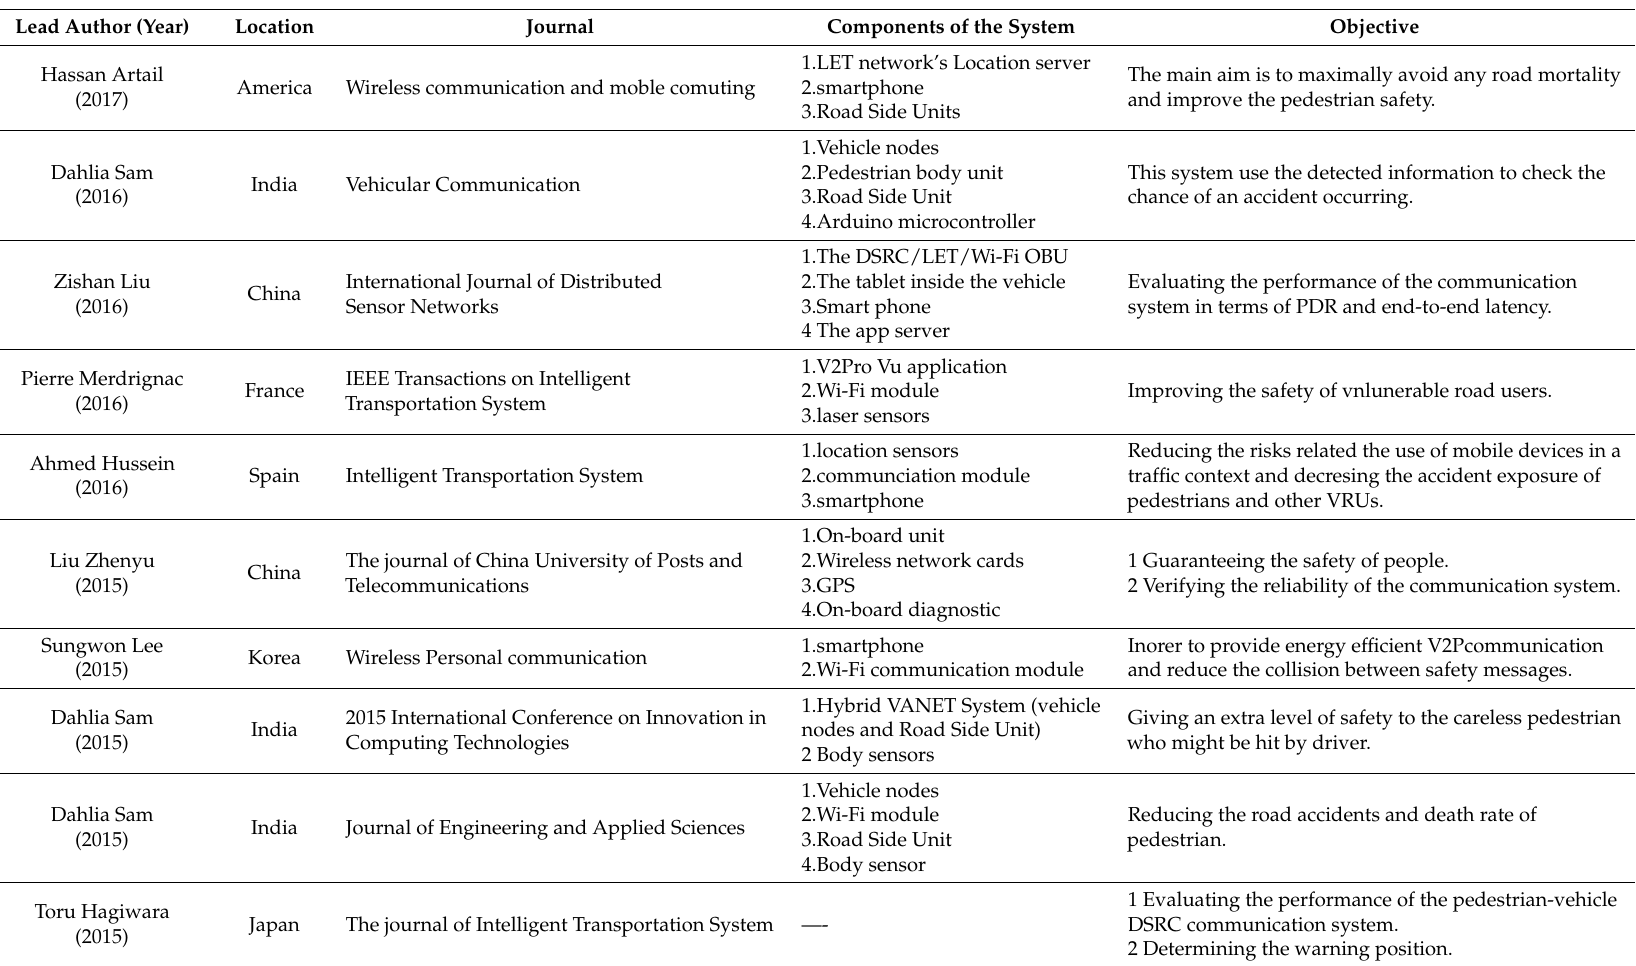
Table 2. Summary of the Selected Papers in this